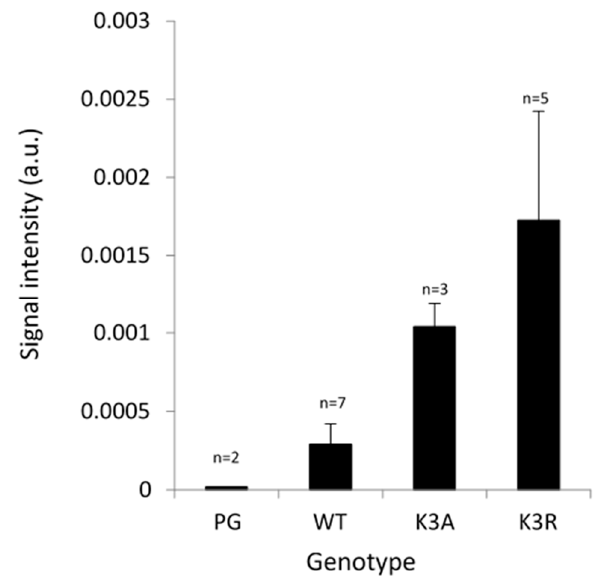
Figure 4. Relative abundance of PIP2 isoforms in Arabidopsis suspension cells overexpressing PIP2;1 WT and carrying a point mutation of K3 in alanine (K3A) and in arginine (K3R). ELISA assays were performed with total protein extracts and anti-PIP2 antibody [19]. The number of independent stable cell lines is indicated. Data were from three individual ELISA assays per cell line. Standard error is